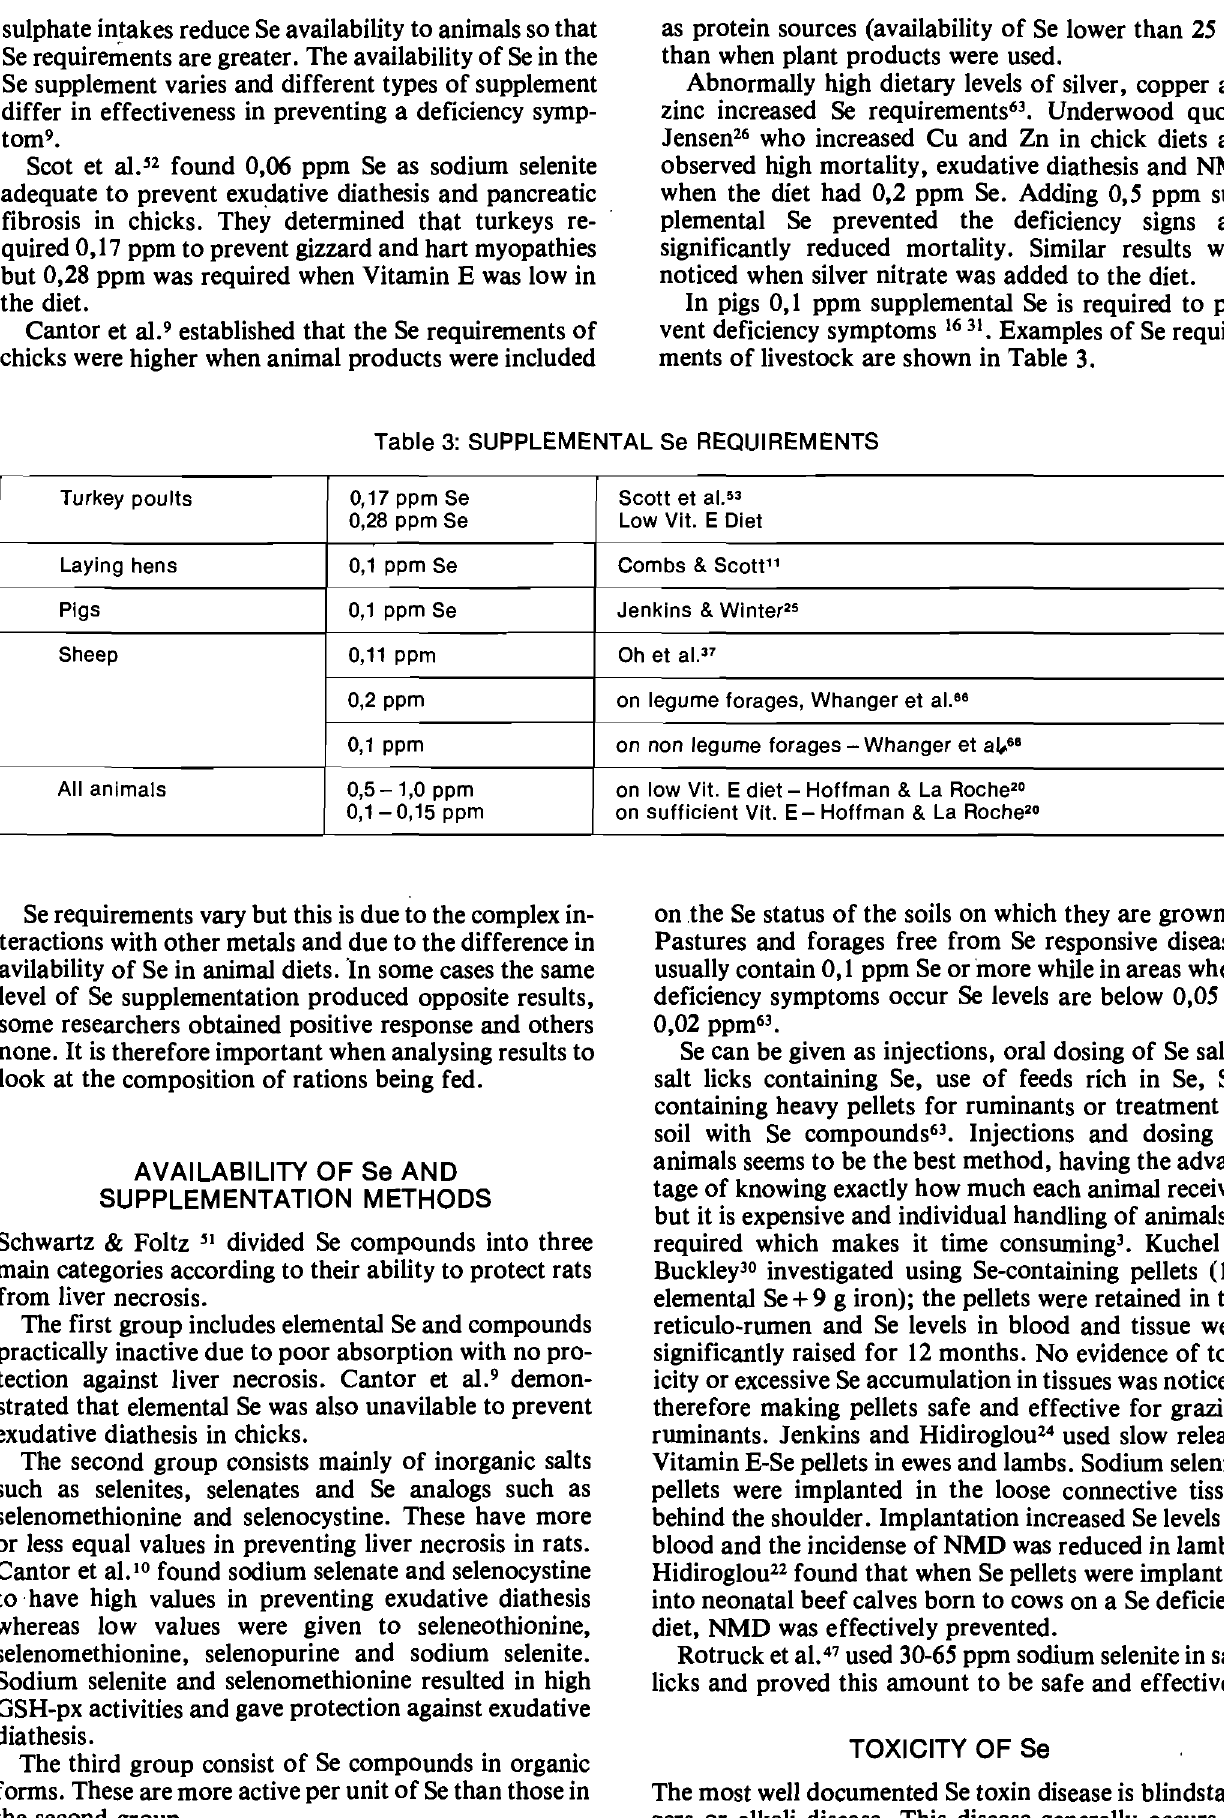
Table 3: SUPPLEMENTAL Se